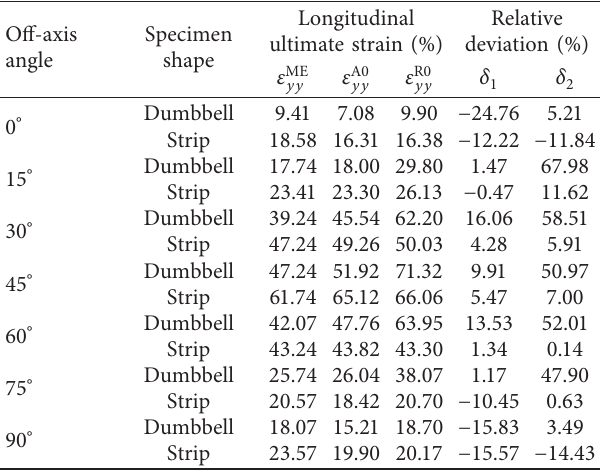
Figure 5: Longitudinal strains measured by the 3D-DIC system and a mechanical extensometer. (a) 0 ° . (b) 15 ° . (c) 30 ° . (d) 45 ° . (e) 60 ° . (f) 75 ° . (g) 90 ° Table 1: Longitudinal ultimate strain of the coated fabrics.